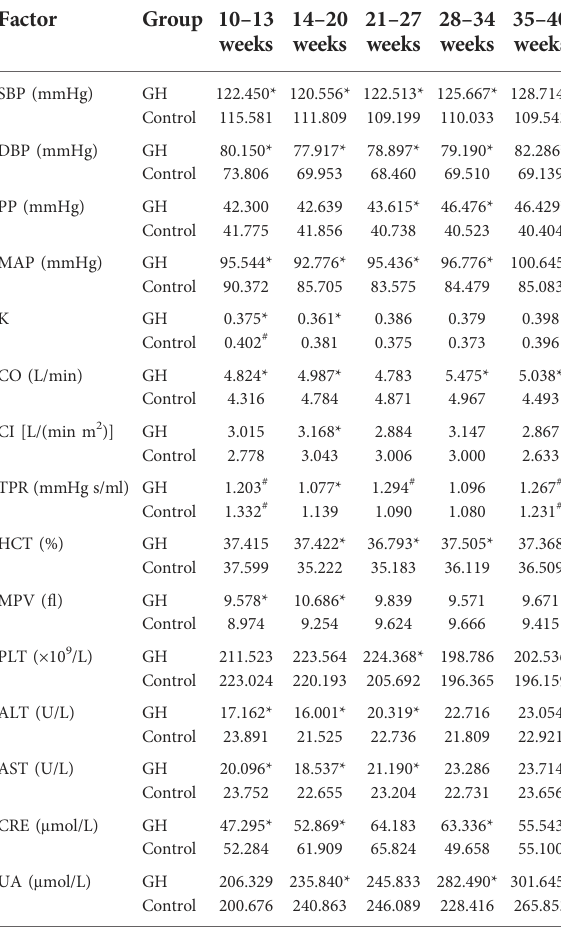
TABLE 8 Dynamic factors analysis of gestational